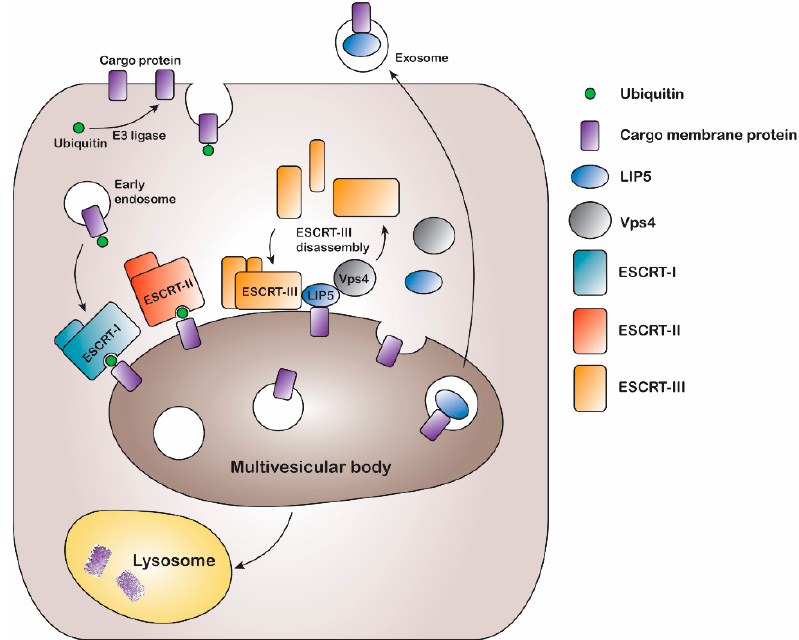
Figure 1. Schematic figure of the multivesicular body (MVB) membrane protein sorting mechanism. Cargo membrane proteins are ubiquitinated by E3 ubiquitin ligases and internalized through endocytosis. After sorting into early endosomes, the cargo membrane proteins interact with ESCRT- complexes I and II in the MVB limiting membrane and are inserted into MVB inner vesicles via actions of ESCRT-III and Vps4. The latter is coordinated by LIP5 which directly binds ESCRT-III and Vps4 and co-localizes with the membrane protein cargo inside the MVB inner vesicles. Finally, the MVBs may fuse with lysosomes, resulting in cargo protein degradation or they may fuse with the plasma membrane upon which the MVB inner vesicles are released extracellularly as exosomes. Black arrows indicate translocation events, attachment of ubiquitin and assembly/disassembly of the ESCRT-III complex.